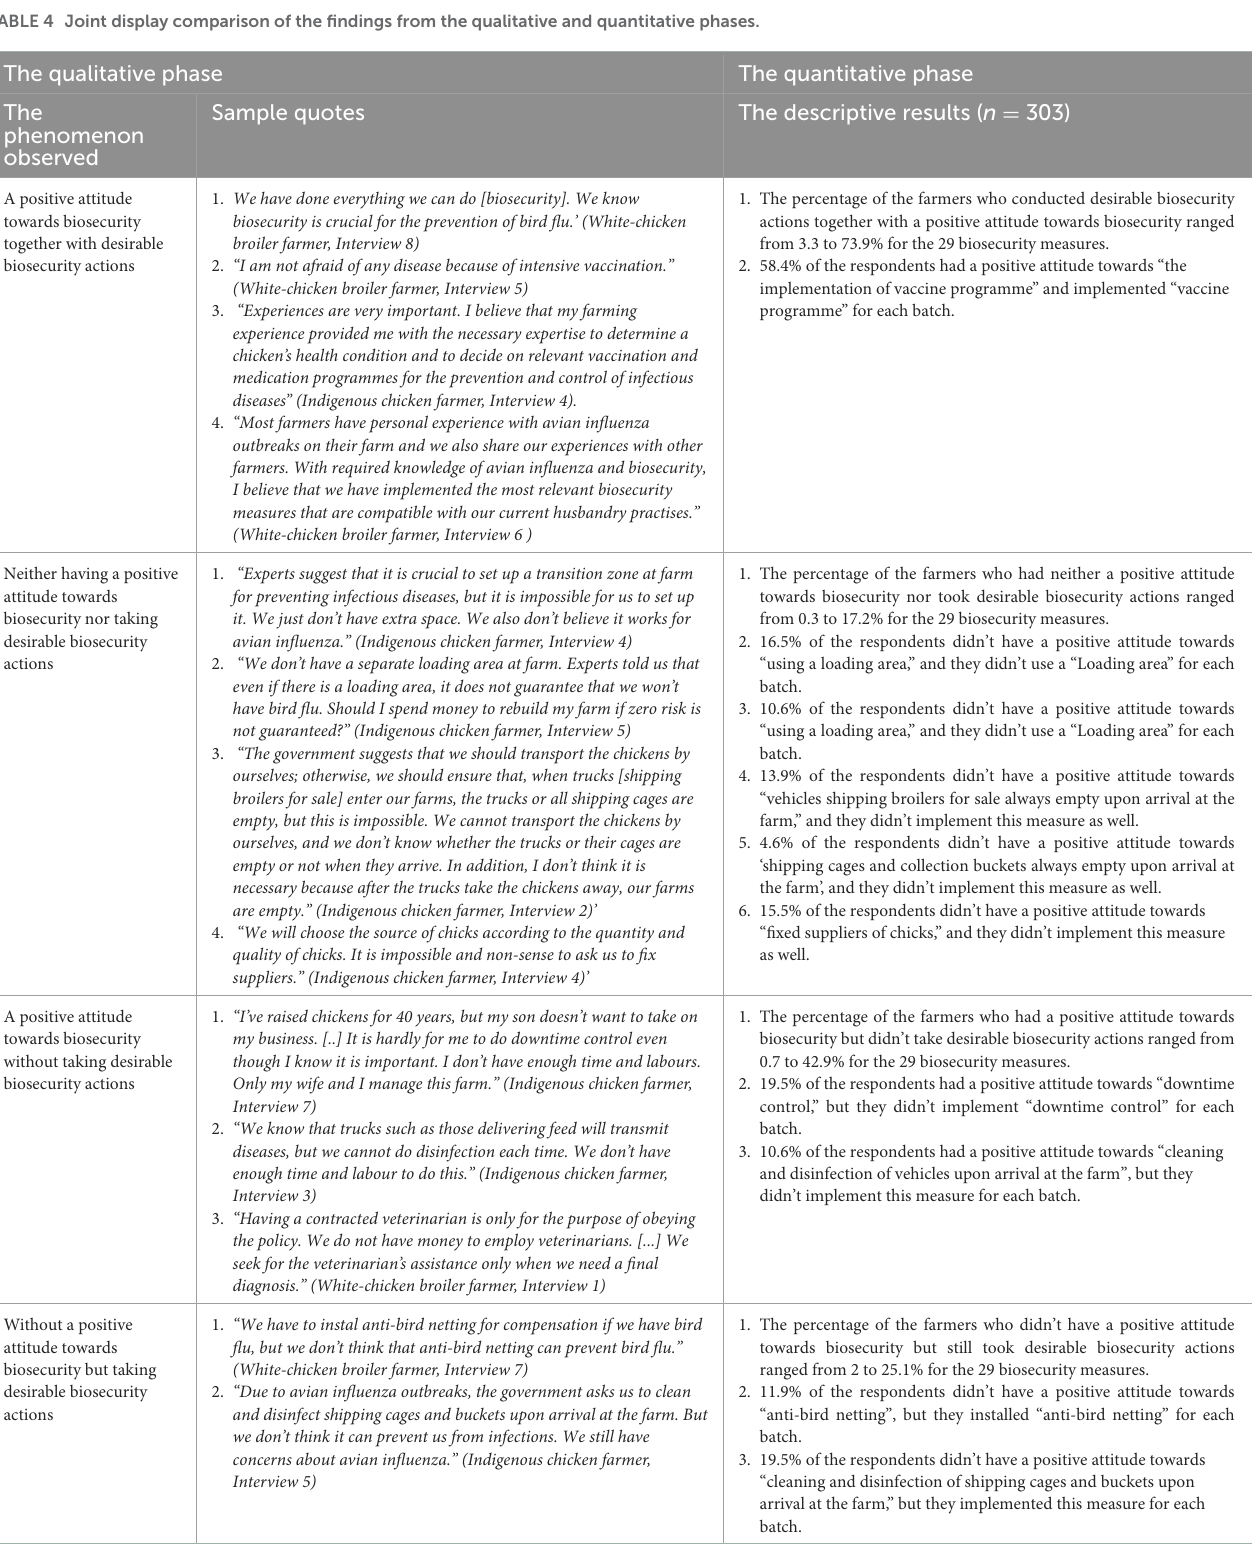
TABLE 4 Joint display comparison of the findings from the qualitative and quantitative